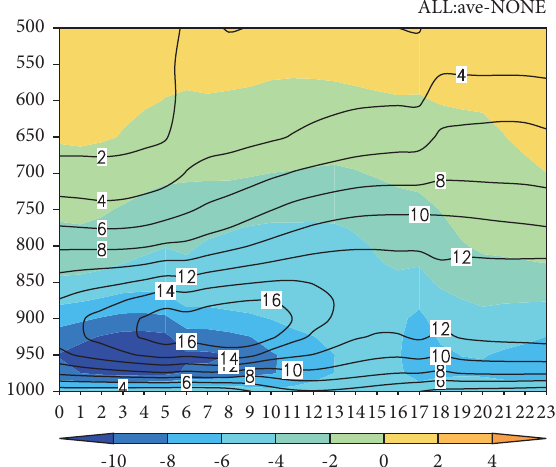
Figure 6: Regional (28 ° N–30.7 ° N, 112 ° E–117 ° E) average diurnal variation of vapor-fux convergence (color, 10 − 8 g kg − 1 s − 1 ) and vorticity (black line, 10 − 6 s − 1